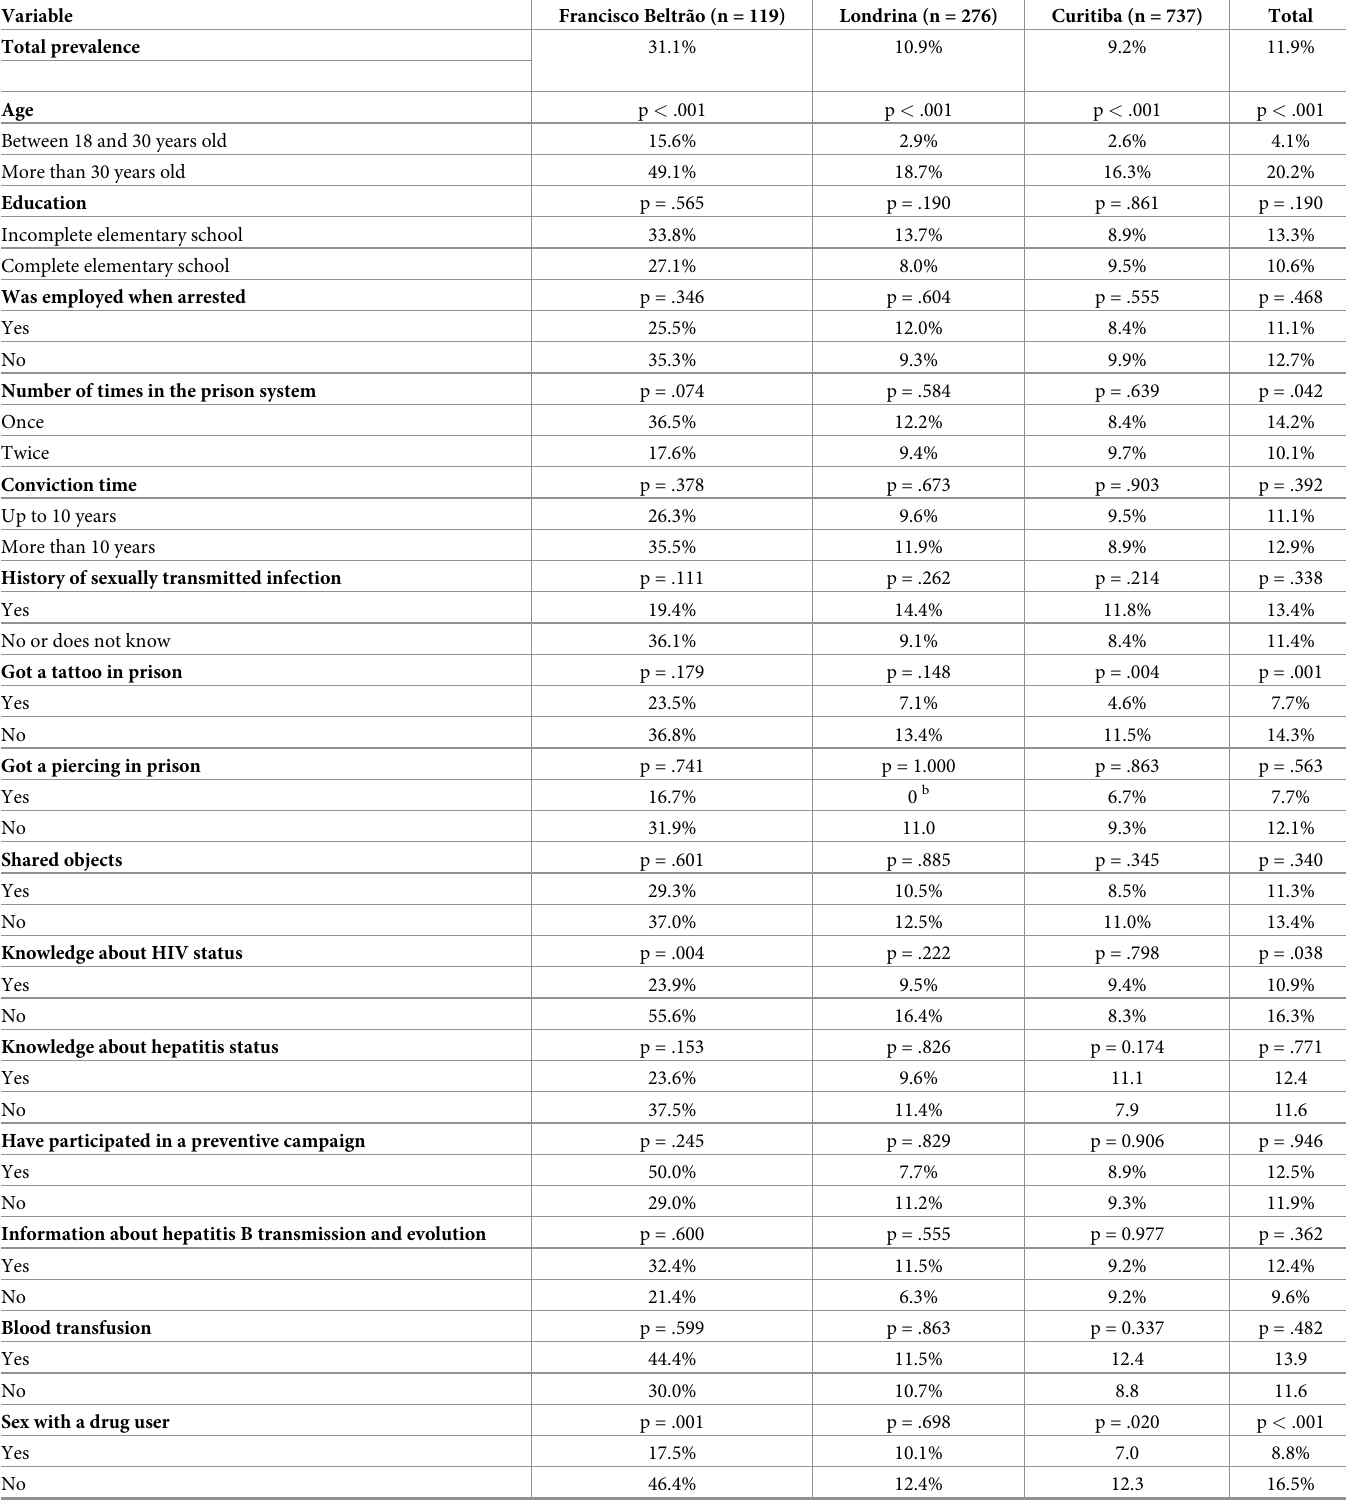
Table 1. Characterization of the sample and seroprevalence of hepatitis B in 11 state penitentiaries in three municipalities of Parana´, Brazil.